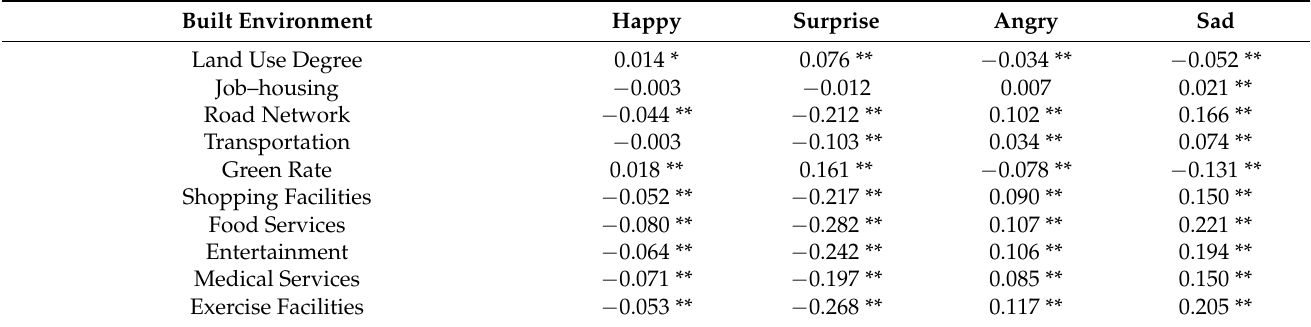
Table 8. Correlation between public sentiment intensity and built environment (scale: 500 m × 500